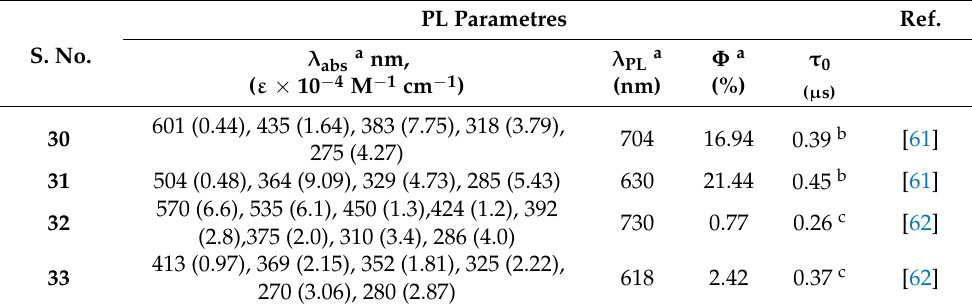
Table 2. Absorption and emission profiles of some selected mono- and bimetallic Pt(II) cyclometa- lated